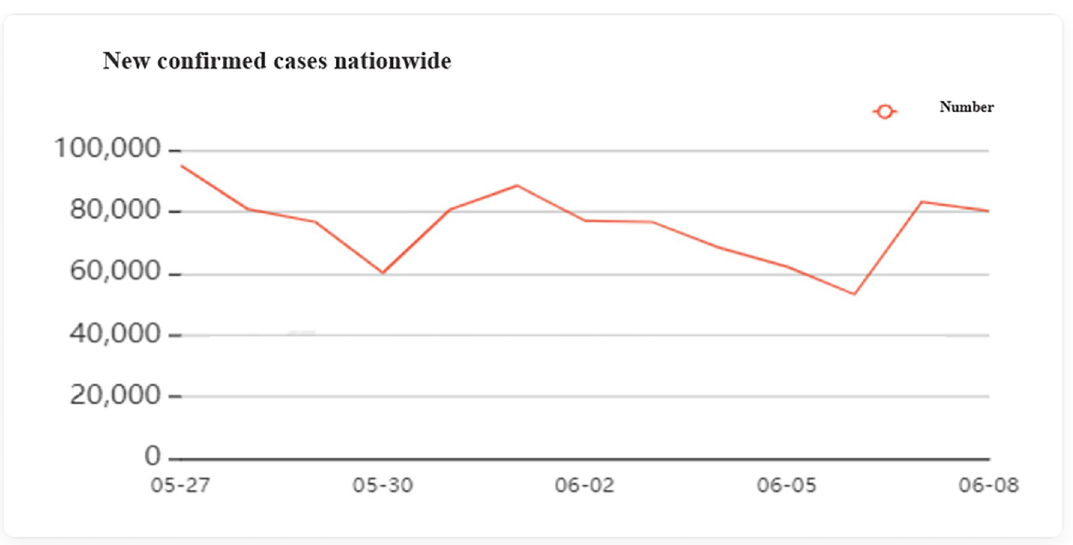
Fig 2. "Lilac Garden" pandemic map real-time broadcast